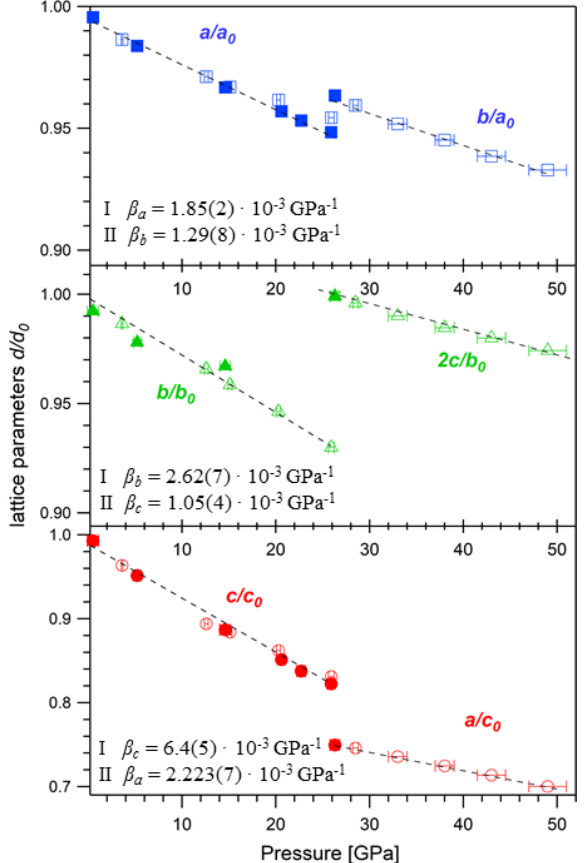
Figure 5. Compressibility of the unit cell parameters β a , β b , and β c for SrCO 3 -I and SrCO 3 -II. Open symbols are data derived from powder samples, and solid symbols are from single-crystal X-ray diffraction. Note that the a , b , and c axes in SrCO 3 -I ( Pmcn ) cor- respond to the b , c , and a axes in SrCO 3 -II ( Pmmn ). The lat- tice parameters at ambient conditions are a 0 = 5 . 126 ( 1 ) Å, b 0 = 8 . 472 ( 2 ) Å, and c 0 = 6 . 061 ( 1 ) Å.